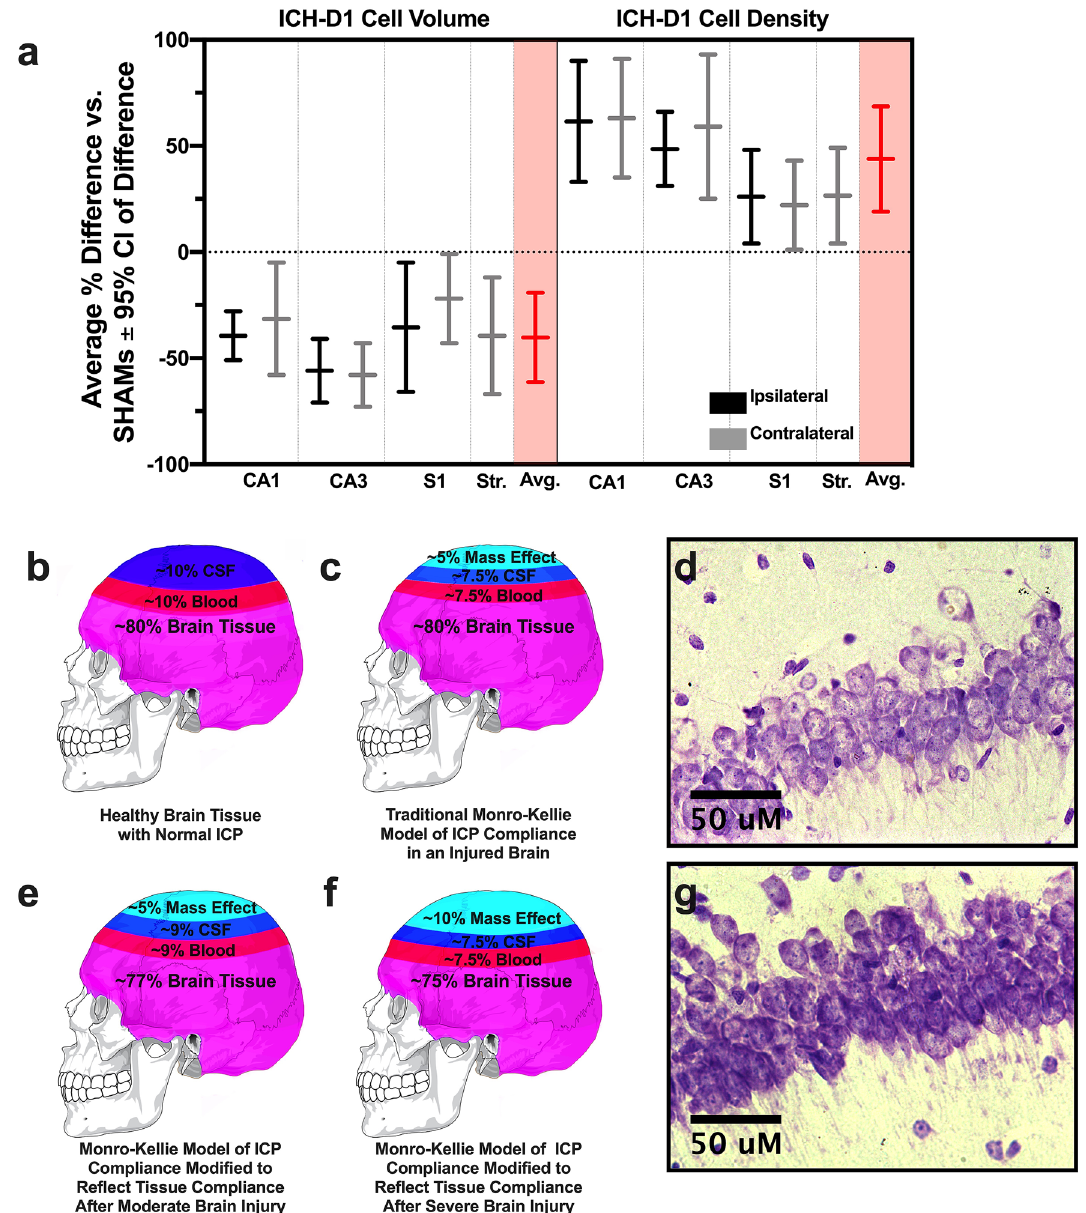
Figure 6. A plot of the D1 effect size (average % difference vs. SHAMs ± 95% CI of difference) for cell volume and density ( a ) across every brain region assessed in experiment 1, along with the overall experimental average effect size for each endpoint (highlighted). The traditional Munro-Kellie model of ICP compliance asserts that once a mass is added to the brain (whether that be edema and/or a hematoma), CSF and vascular blood are redirected to reduce rising ICP ( b , c ). In our proposed modification, the increase in neuronal packing density and reduction in cell volume that we observed in both ICH and MCAO kick in as ICP rises, aiding in compliance and reducing the required displacement of vascular blood and CSF ( e ), especially after large strokes ( f ). This may aid in avoiding secondary ischemic injury due to reduced cerebral blood flow, and potentially helps prevent transforaminal herniation. Lastly, representative cresyl violet images of hippocampal layer CA1 in both ipsilateral ICH-D1( d ) and SHAM ( g ) tissue are shown to illustrate the tissue compliance phenomenon. Cresyl violet images were taken at 40 × magnification, and cranium diagrams (derivative of Creative Commons